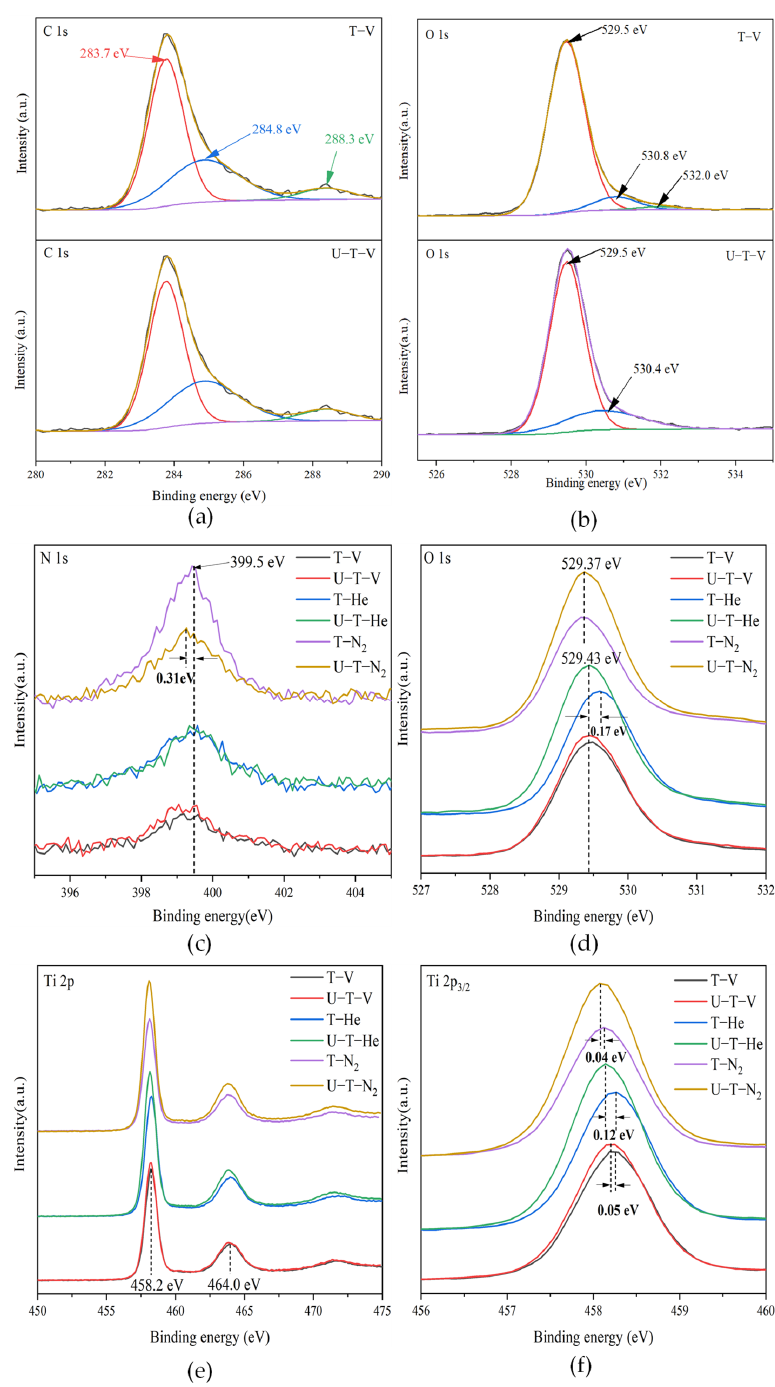
Figure 3. High-resolution XPS of ( a ) C 1s of T-V and U-T-V; ( b ) O 1s of T-V and U-T-V; ( c ) N 1s; ( d ) O 1s; ( e ) Ti 2p; ( f ) enlarged Ti 2p3/2 of the as-prepared samples.